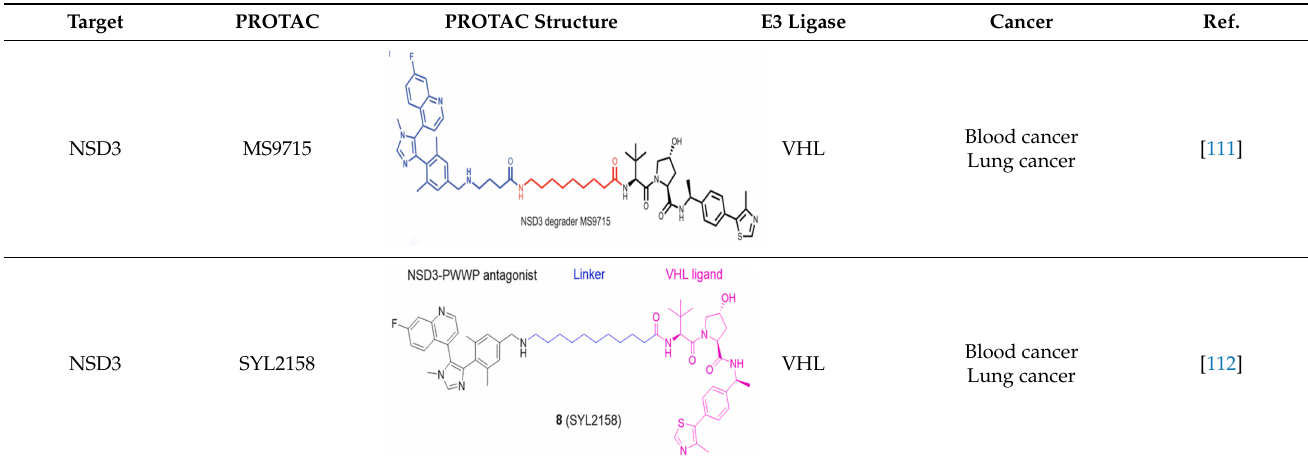
Table 3. PROTACs for Histone methylation targets